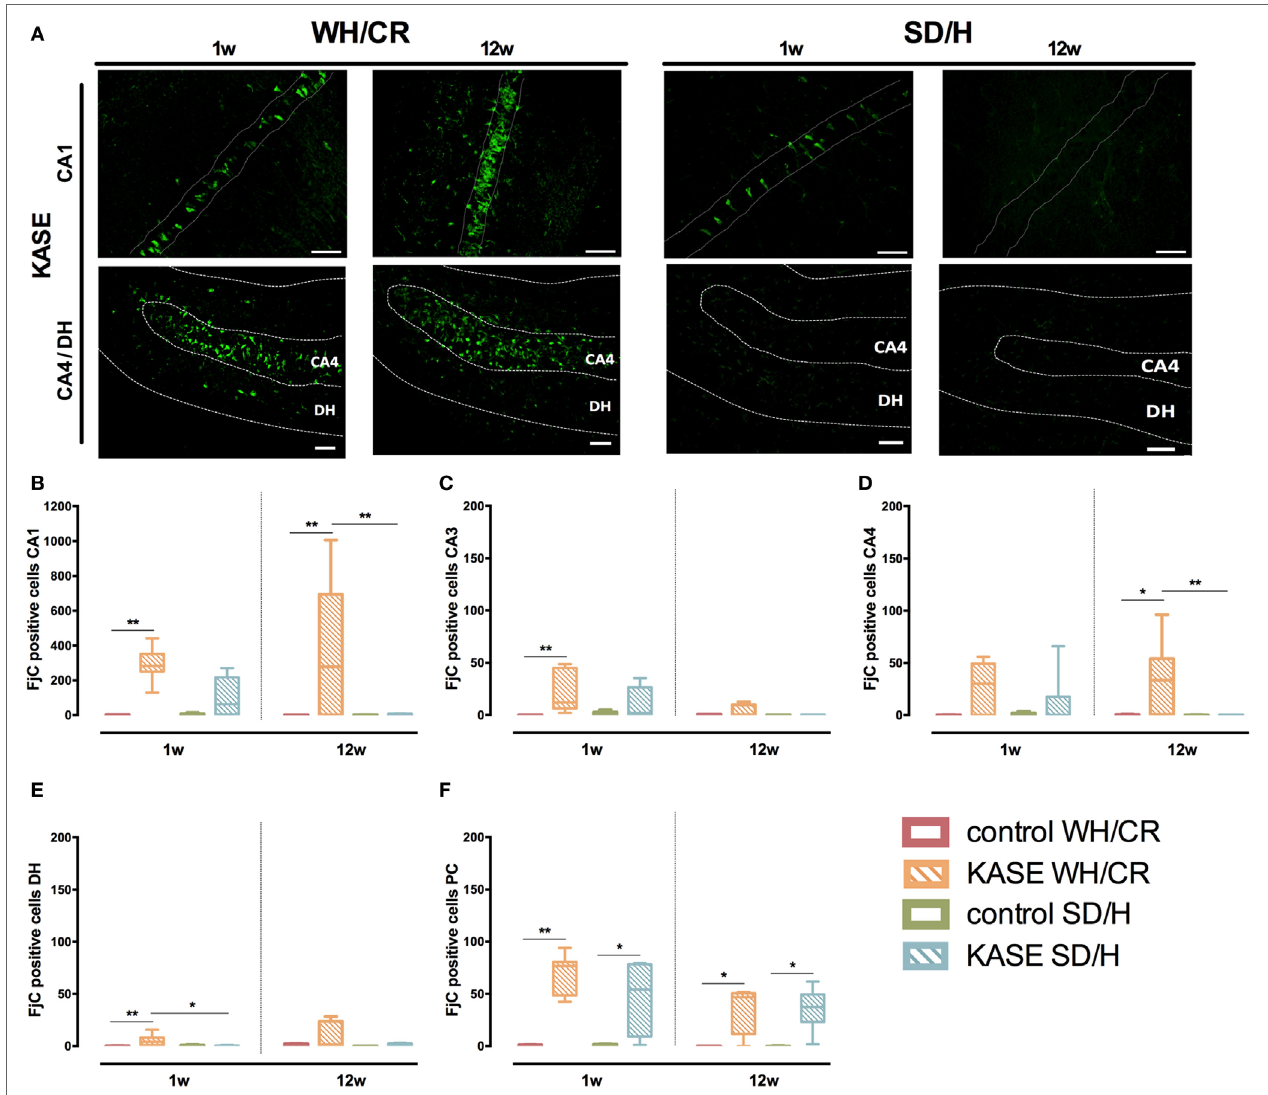
FigUre 7 | Neurodegeneration in KASE WH/CR and KASE SD/H rats. (a) Representative CA1 and CA4/DH images for KASE rats 1 and 12 weeks post-status epilepticus (SE). During both subacute and chronic phases, KASE WH/CR displayed an overall more extensive neurodegeneration than KASE SD/H in the investigated regions (B–F) . Kruskal–Wallis test with post hoc Dunn’s test (B–F) . * p < 0.05, ** p < 0.01. One week post-SE: control WH/CR n = 4–5, KASE WH/CR n = 8–10, control SD/H n = 5 and KASE SD/H n = 6; 12 weeks post-SE: control WH/CR n = 5–6, KASE WH/CR n = 7, control SD/H n = 4–6 and KASE SD/H n = 6. Representative images: CA1 = 40 × magnification, CA4/DH = 20 × magnification. Scale bar = 50 µm. WH/CR, Wistar Han/Charles River; SD/H, Sprague-Dawley/Harlan; w, week; CA, cornu ammonis; DH, dentate hilus; PC, piriform cortex; KASE, kainic acid-induced status epilepticus